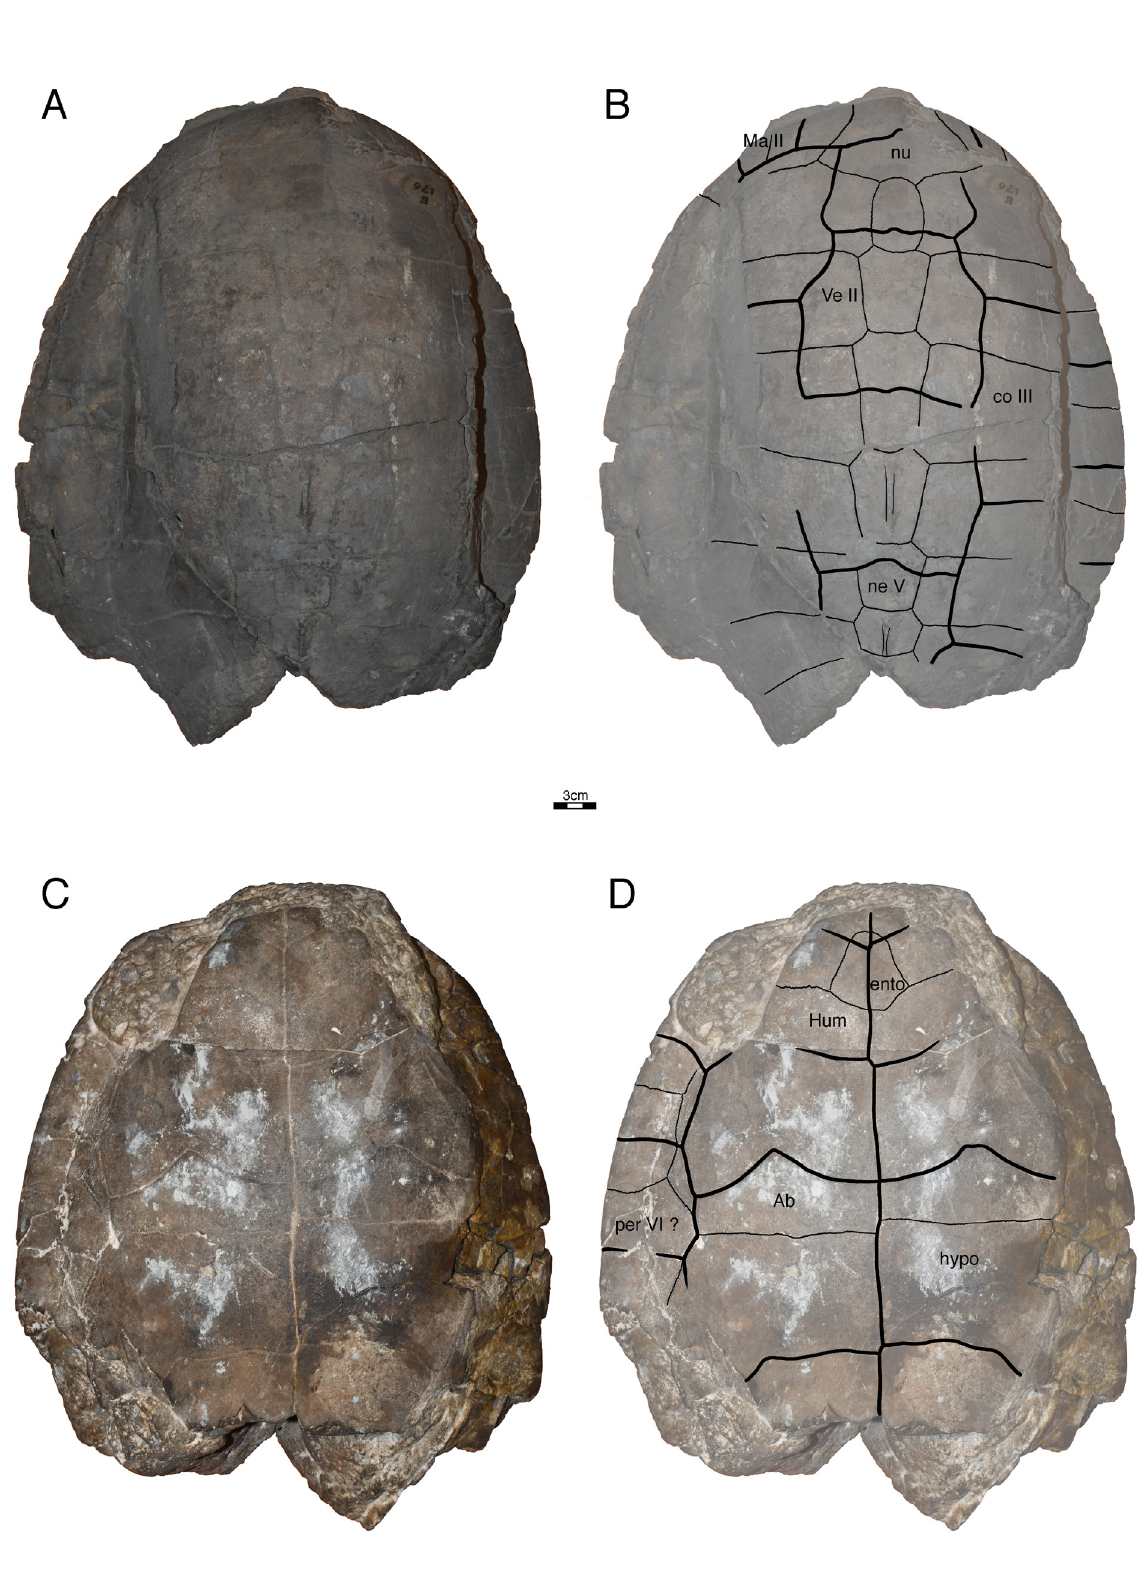
Fig. 11. IM E.176, previously undescribed, here identified as Batagur sp. A . Photograph of carapace. B . Illustration of carapace. C . Photograph of plastron. D . Illustration of plastron. Scale bar: